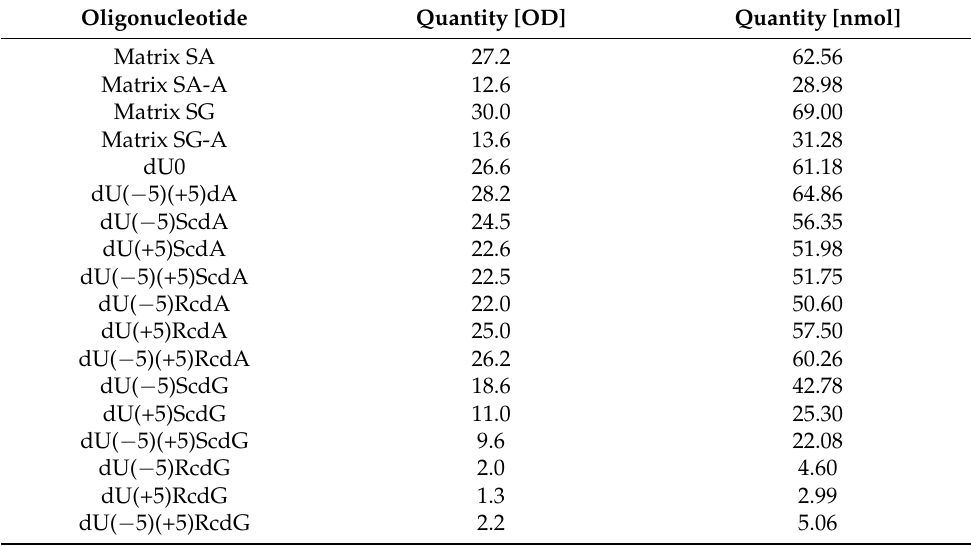
Table 2. The obtained quantities [OD] and [nmol] of oligonucleotides.